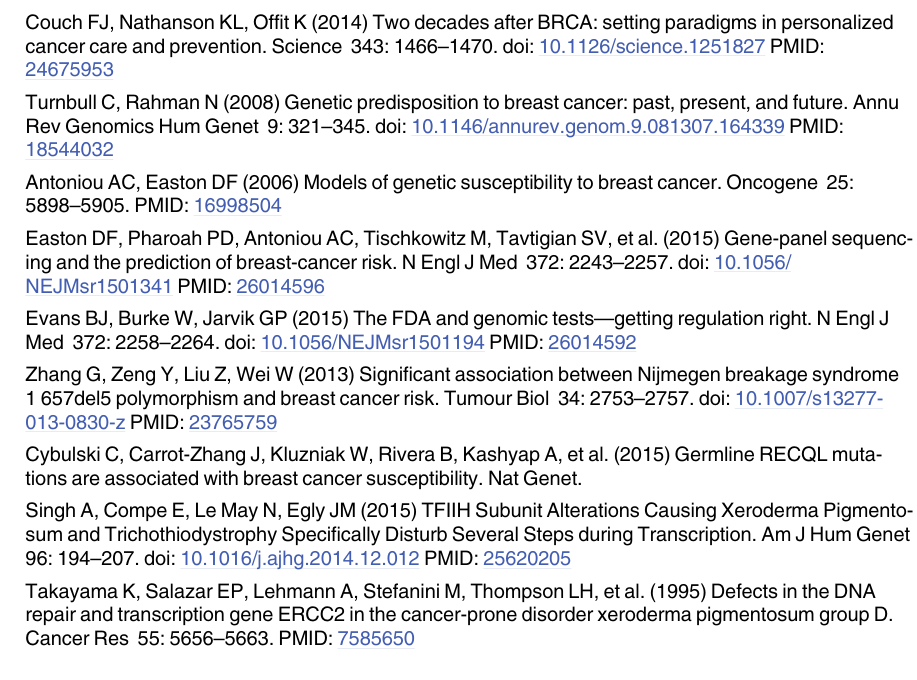
S2 Table. ERCC2/XPD primers for Sanger-validation of NGS derived mutations and analy- sis of familial segregation. All sequences shown in 5 ’ ! 3 ’ direction. XPD = alternate name of ERCC2 . S3 Table. Primer pairs used for PCR amplification, Sanger sequencing, and site directed mutagenesis of ERCC2 variants. All primers (de-salted and deprotected) were synthesized by Sigma-Aldrich (Taufkirchen, Germany). S4 Table. Effect prediction of ERCC2 missense variants. The probability of effect of non-syn- onymous mutations in ERCC2 was predicted by the computer programs: SIFT, Sorting Invari- ant from Tolerated (Score under 0,05: not tolerated; Range 0 – 1); PolyPhen-2, Classification following PSIC scores (HumVar, "benign" - "possibly damaging “ — "probably damaging ", Range: 0 – 1); Provean, Protein Variation Effect Analyze; MAPP, Multivariate Analysis of Pro- tein Polymorphism; Align-GVGD, Scores (C0, C15, C25, C35, C45, C55, C65) from C0 (likely benign) to C65 (likely pathogenic); CADD, Combined Annotation Dependent Depletion [12]. Dlt = deleterious, PrD = probably damaging, PsD = possibly damaging, Bgn = benign, Ntr = neutral. Conservation was calculated with PhyloP (Score range from -14.1 to 6.4). Grantham [35] distance scores (Range 0 – 215). AA exchanges in gray background are located in cis and form a